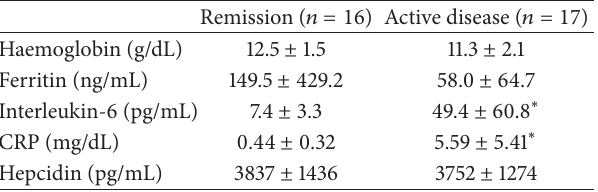
Table 3: Comparison of anaemia parameters, hepcidin levels, and inflammatory markers between Crohn’s disease patients with different disease activities.